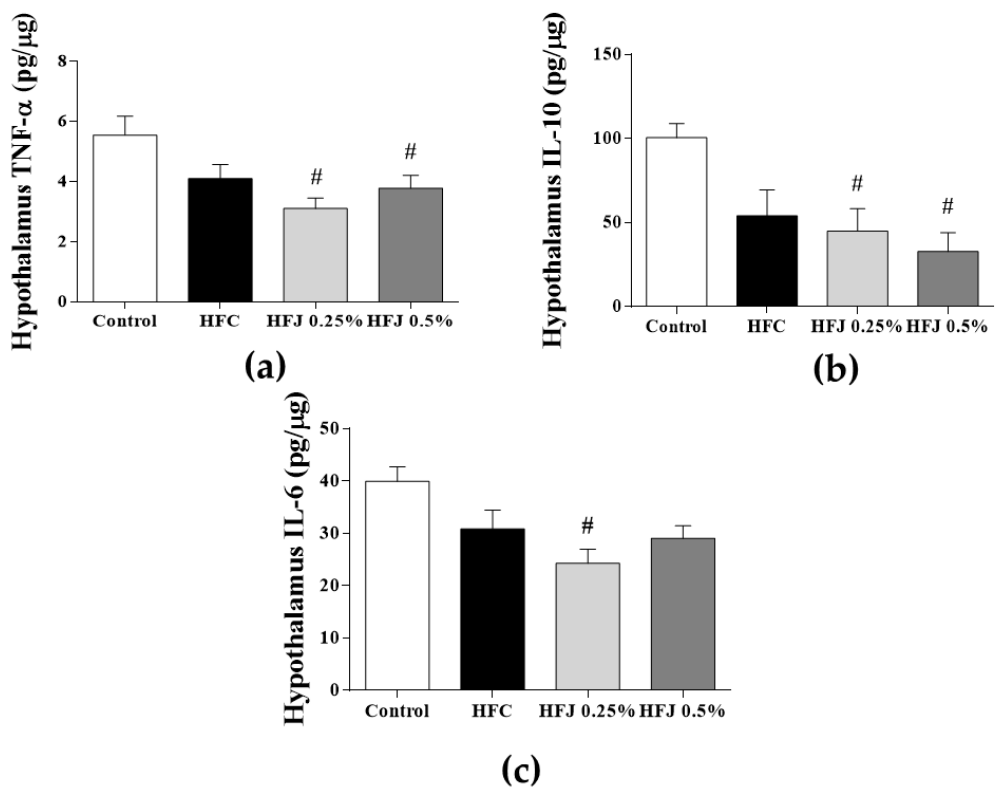
Figure 2. Cytokine levels of protein extract samples from the hypothalamus: ( a ) TNF- α , ( b ) Il-10, and ( c ) IL-6. * p < 0.05 compared with the high-fat juçara 0.25% (HFJ 0.25%) group; # p < 0.05 compared with the control diet (C) group ( n = 6 or 7).